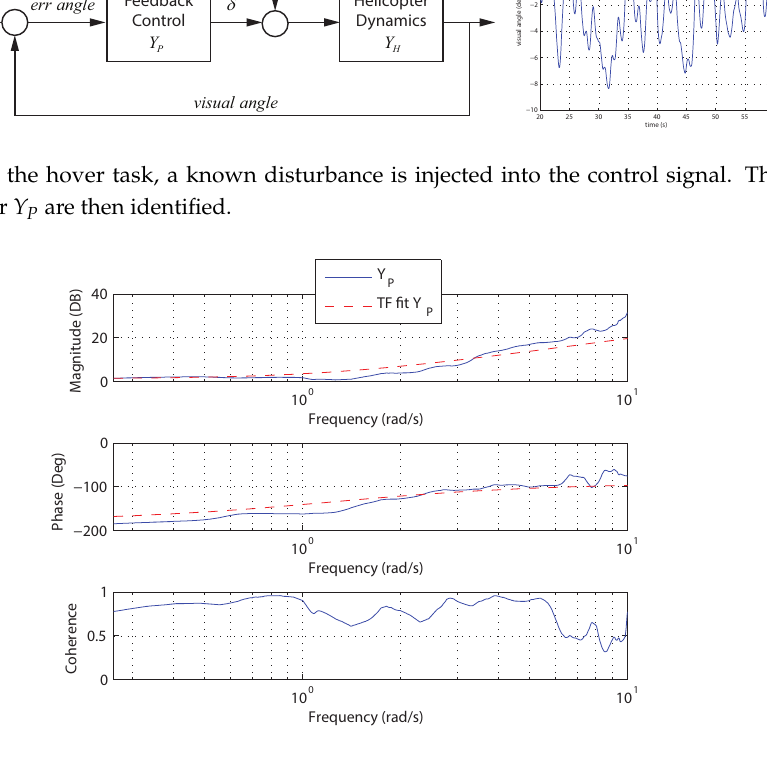
Figure 10. The control parameters are then identified using system identification